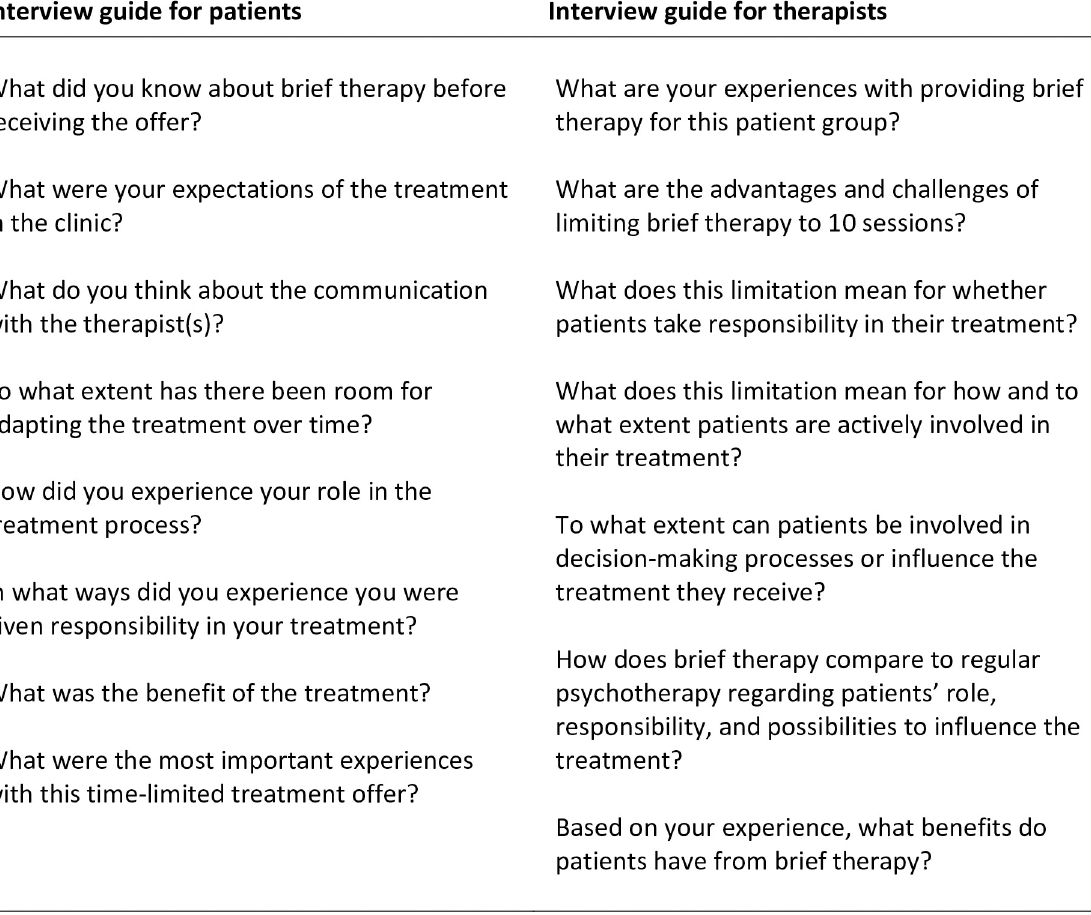
Fig 1. Guide for interviews with patients and therapists. A treatment strategy for meeting life as it is. Patients’ and therapists’ experiences of brief therapy in a district psychiatric centre—a qualitative study.